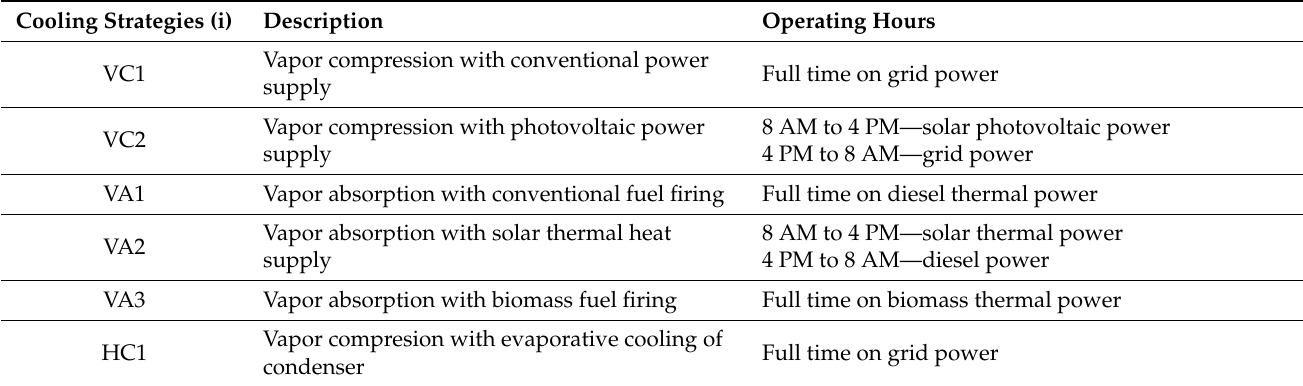
Table 2. Cooling Strategies and their Operating time and type of fuel